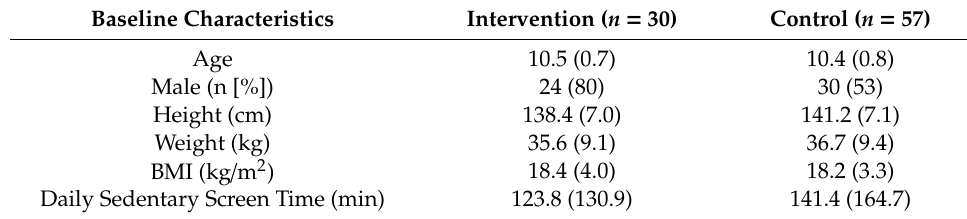
Table 1. Baseline Characteristics of All Participants (N =